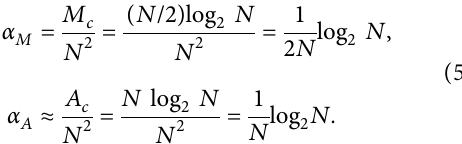
M and α A with N .